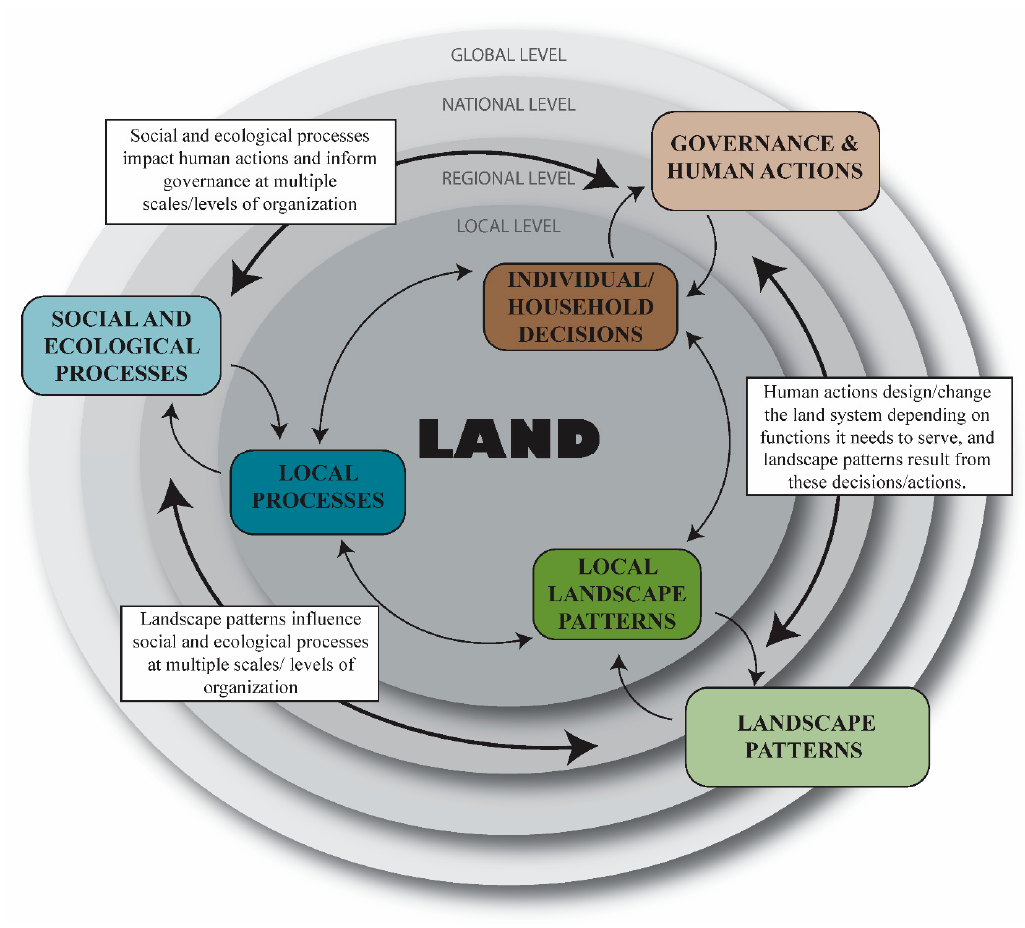
Figure 2. Proposed framework for CHANS studies. Linkages between human action, landscape patterns, and social and ecological processes occur at each level—the local level is highlighted here, with governance as an example. Multi-level/scalar couplings between the individual components also occur across levels/scales.